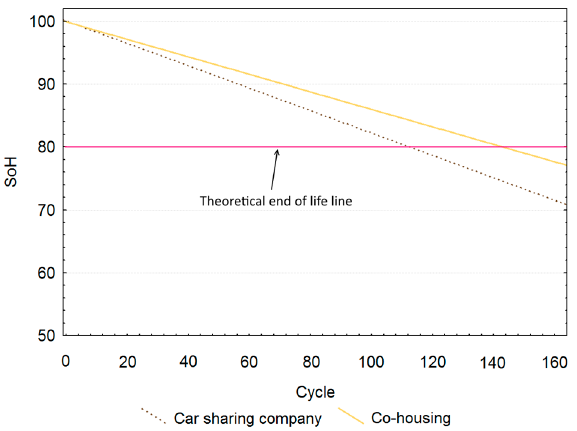
Figure 12. SoH ’s linear trends extrapolation and theoretical end of life border.